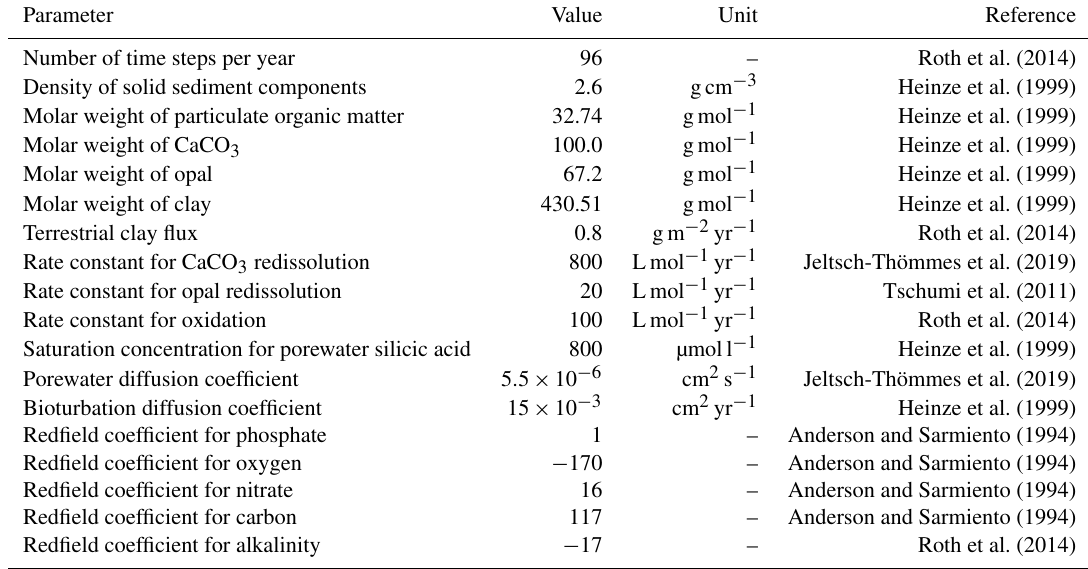
Table B1. Parameters used for the sediment module, similar to what is shown in Appendix A of Tschumi et al. (2011) and with updates from Roth et al. (2014) and Jeltsch-Thömmes et al.